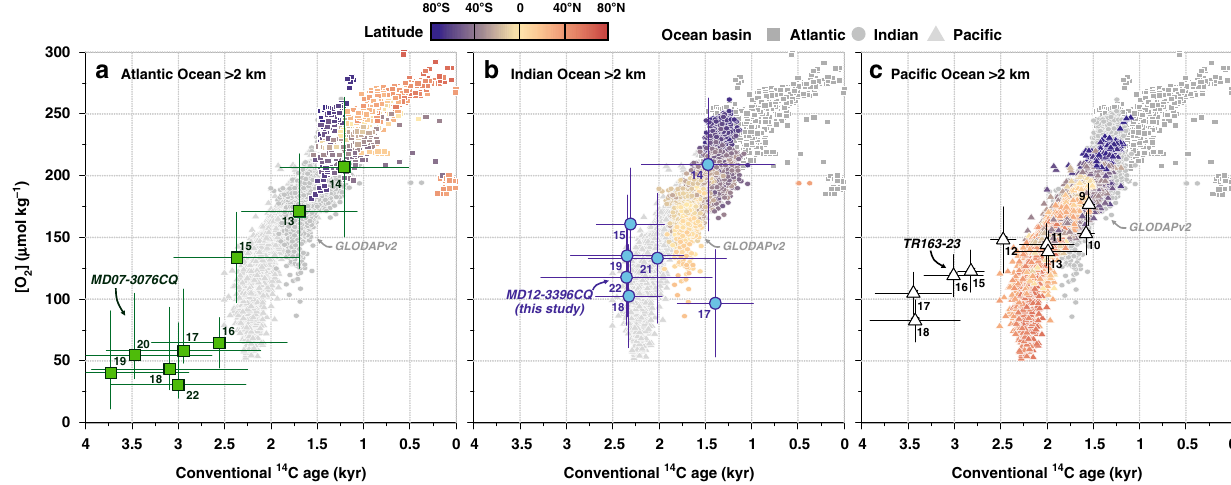
Fig. 7 Relationship between seawater oxygen concentrations and conventional radiocarbon ages at present-day and in the past. Modern seawater [O 2 ] levels versus conventional 14 C age in a the Atlantic Ocean (squares), b Indian Ocean (circles), and c Paci fi c Ocean (triangles) below 2 km water depth 28 ; modi fi ed after ref. 4 . Symbol color represents the latitude of the seawater sample. Large symbols show reconstructed bottom water [O 2 ] (via the Δδ 13 C proxy) and ventilation ages (i.e. d 14 R B-Atm , representing paleo-conventional 14 C ages) from the deep South Atlantic (green: MD07-3076CQ, 3.8-km water depth) 5,6 , the deep South Indian (blue, this study: MD12-3396CQ, 3.6-km water depth) and the deep Eastern Equatorial Paci fi c Ocean (black: sediment core TR163-23, 2.7 km water depth 72,73 ; please note that Holocene Δδ 13 C proxy data in this core overestimate present-day bottom water [O 2 ] in the study region by ~80 µ mol kg − 1 ). Symbol labels indicate temporal bins over which the paleo- 14 C-[O 2 ] data were averaged (in kyr before present (BP), e.g. for 15 kyr BP: 15.99 – 15 kyr BP). The principal trend of increasing ventilation ages with decreasing seawater oxygen content can be ascribed to the accumulation of respired carbon, while deviations from this trend can be driven by the advection of well-ventilated water masses, e.g. from the Weddell Sea ([O 2 ] increase without 14 C change), or through organic carbon respiration in upwelling regions ([O 2 ] decrease without 14 C change) 4 . On multi-millennial timescales, the respiration rate may change (causing the 14 C-[O 2 ] slope to steepen or fl atten), and the ocean-atmosphere 14 C and O 2 equilibration timescales change with varying atmospheric CO 2 levels (i.e. mean reservoir ages increase in a glacial 190 ppm-CO 2 atmosphere without [O 2 ] change) 50 and ocean temperature/salinity (i.e. [O 2 ] saturation increases without 14 C change during glacials) 51